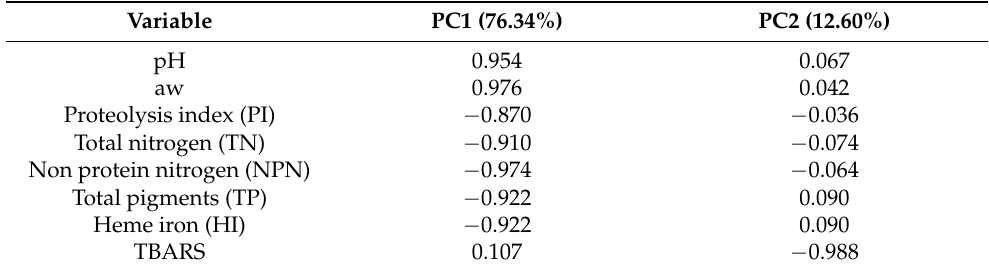
Table 5. Correlation of variables to factors in principal component analysis based on factor